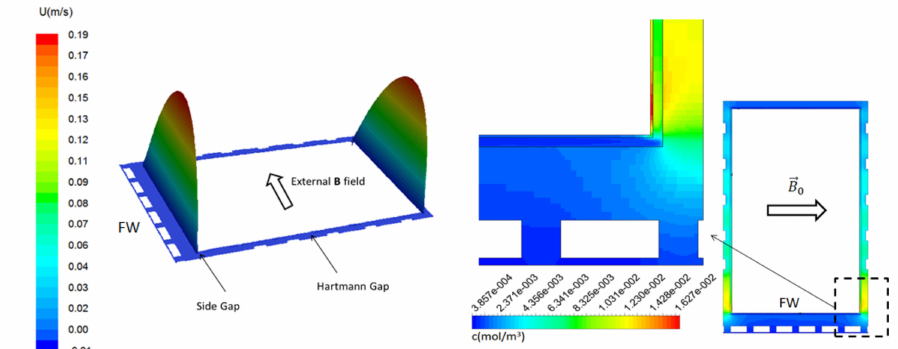
Figure 15. Left: fully developed velocity profile in the gap of a central outboard poloidal channel of a DCLL blanket for Ha = 7630 and ∂ p / ∂ x = 1740 Pa/m. Right: tritium concentration contours in the middle section of the PbLi channel, including PbLi gap, Eurofer walls and external Eurofer layer of the